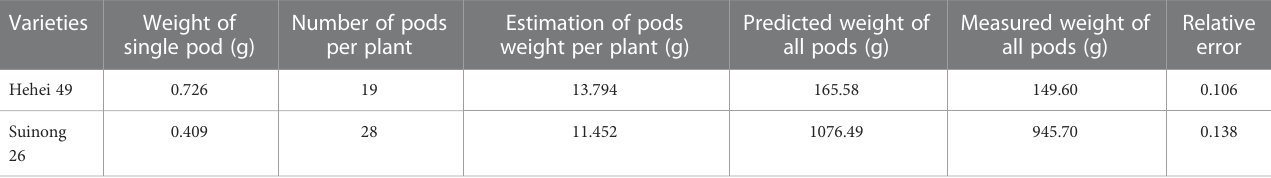
TABLE 5 Prediction information of potted soybean yield.